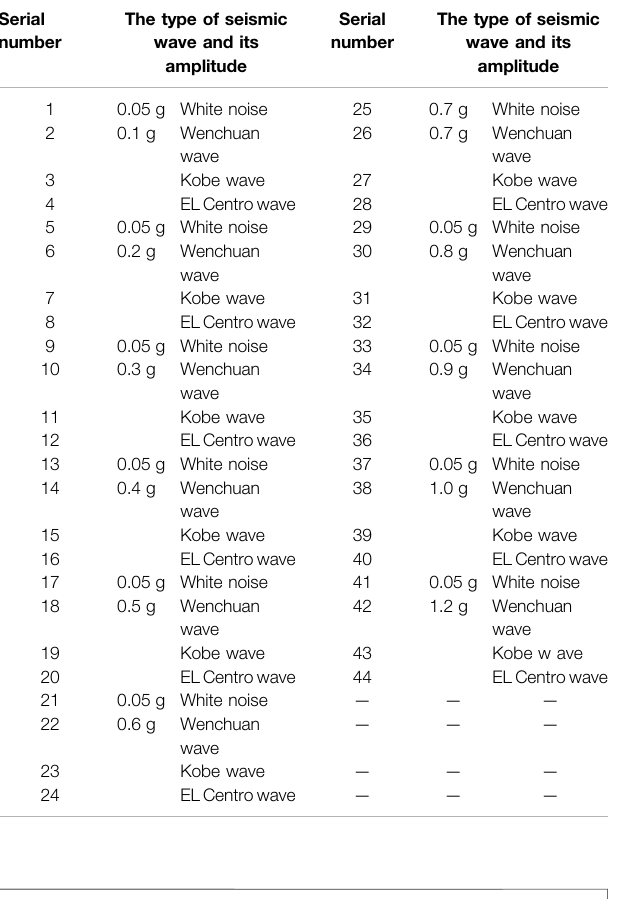
TABLE 2 | Loading conditions of shaking table test.